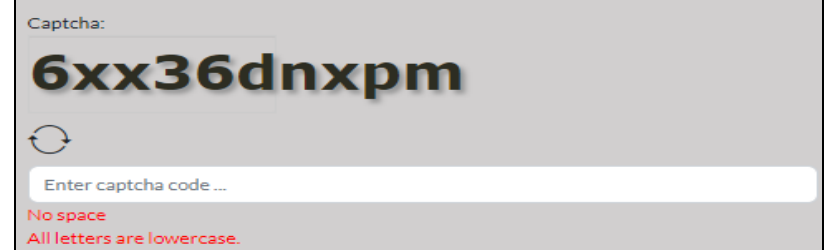
Figure 4. A generated